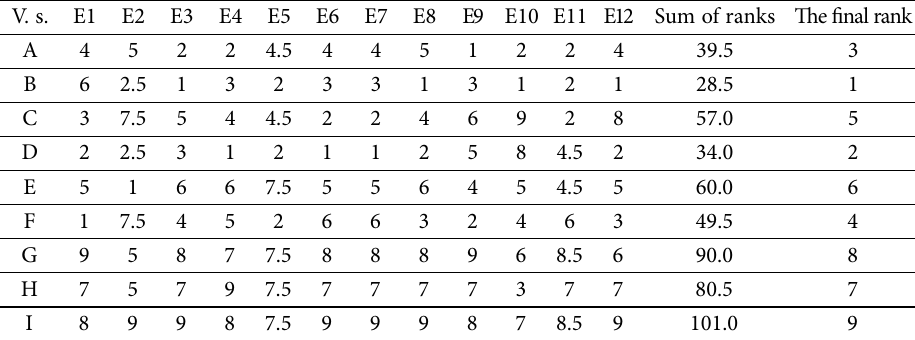
Table 1. Ranking the groups of factors in the commercial potential of technologies V. s. E1 E2 E3 E4 E5 E6 E7 E8